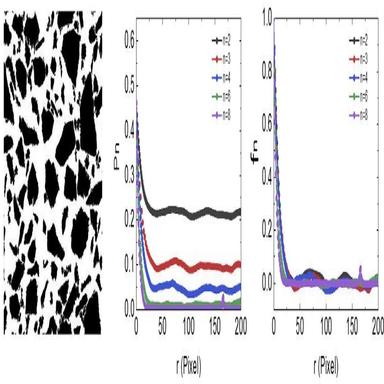
(a) 2D image of a Fontainebleau sandstone microstructure composed of the rock phase (shown in black) and the pore phase (shown in white). (b) The Pn functions for the rock (black) phase with n ¼ 2, 3, 4, 6 and 8. (c) The corresponding rescaled fn functions highlighting the spatial correlations (c.f. Eq..